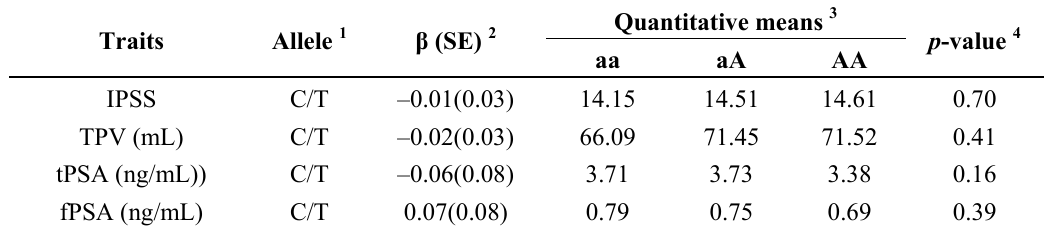
Table 3. Association results for rs103294 on LILRA3 and clinicopathological traits. Traits Allele 1 β (SE) 2